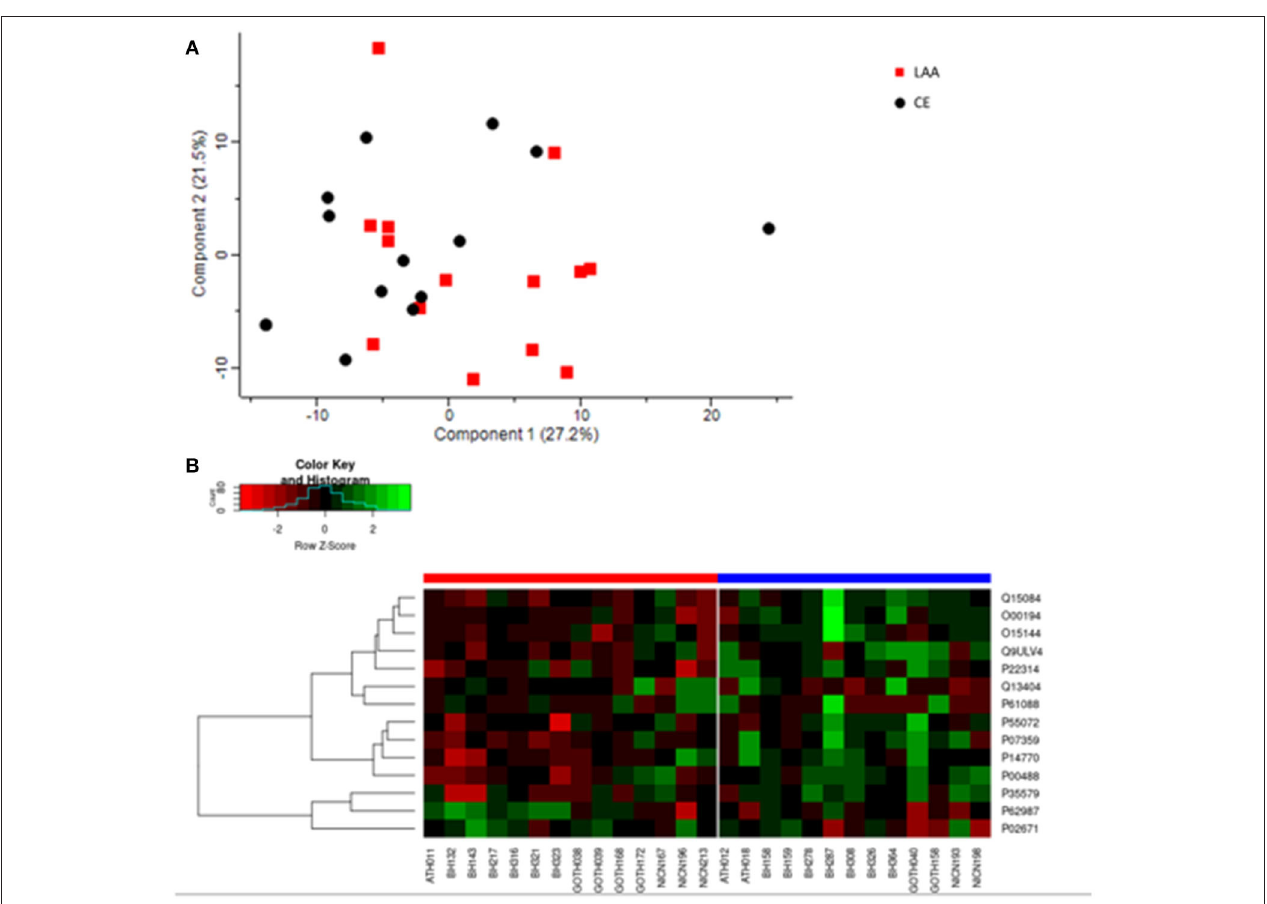
FIGURE 2 | (A) Principal component analysis of the general proteome of FFPE AIS clots. LAA clots are indicated with red squares and Cardioembolic (CE) clots are represented by black circles. Each shape indicates individual samples. Component 1 and 2 explain the 27.2 and 21.5% of the sample variation, respectively. (B) Heatmap depicting differential expression of the significantly abundant protein groups in LAA (red bar on the left) and CE (blue bar on the right) clots. Protein groups are on the right and indicated with their UniProt ID. In the heatmap, red indicates a decrease in protein abundance, while green indicates an increase in protein abundance.